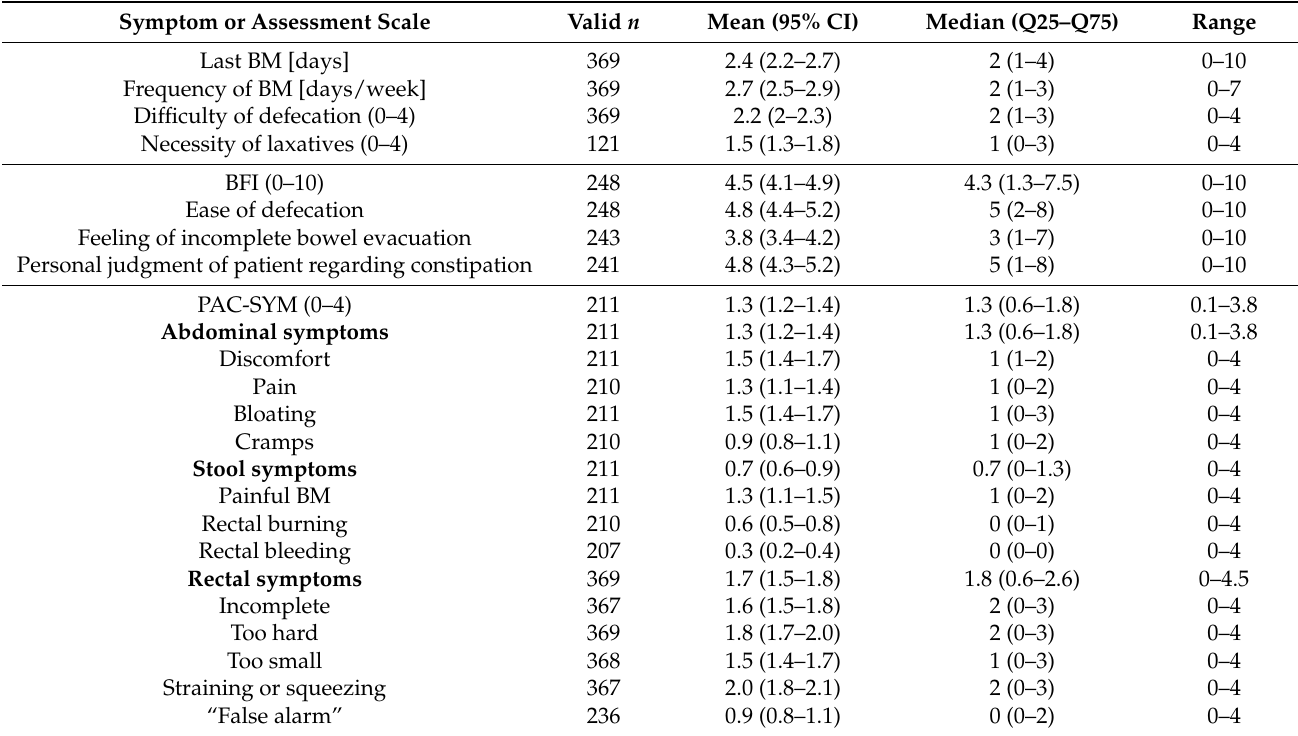
Table 2. Symptoms of constipation and assessment